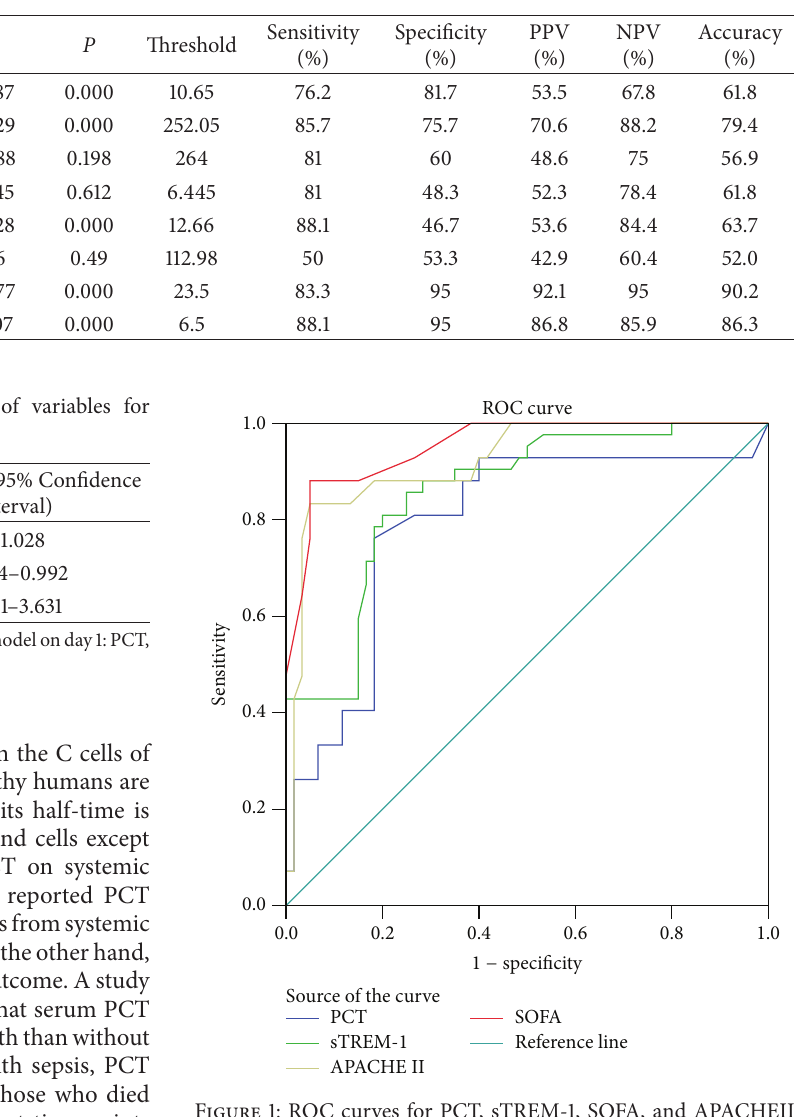
Table 3: Univariate predictors of 28-day mortality on admission based on ROC.